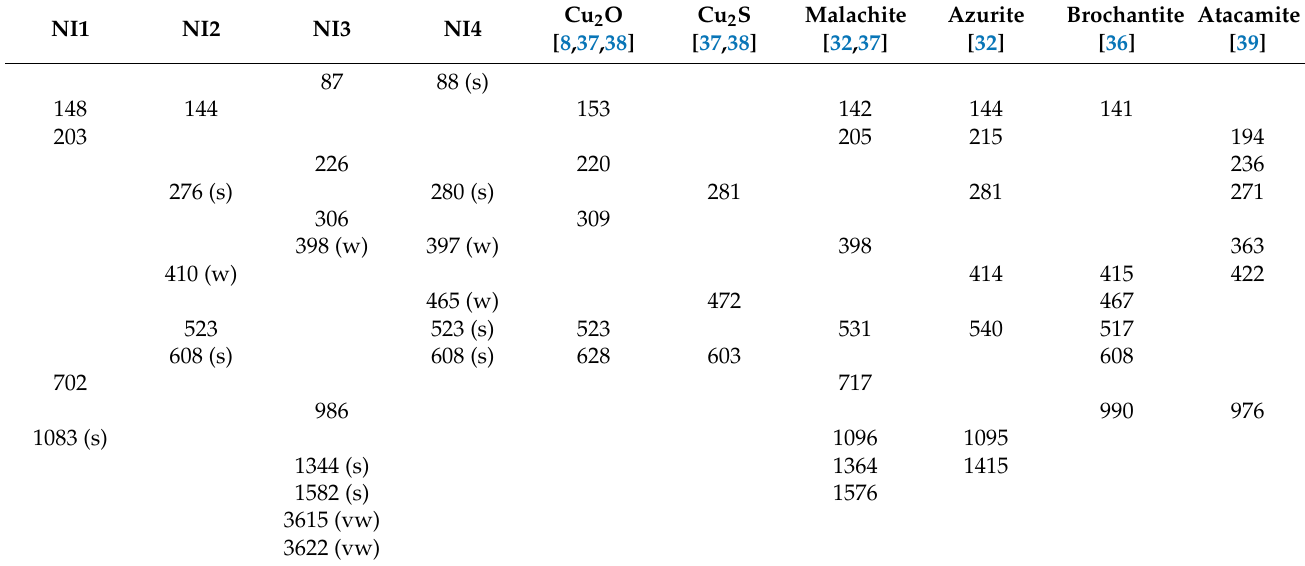
Table 2. Raman bands (cm − 1 ), identified on patinas, analyzed at different positions of the statue NI (Figure 4) and literature data [32,36–39]. Letters next to a number denote strength of the band: vw (very weak), w (weak), s (strong), and vs (very